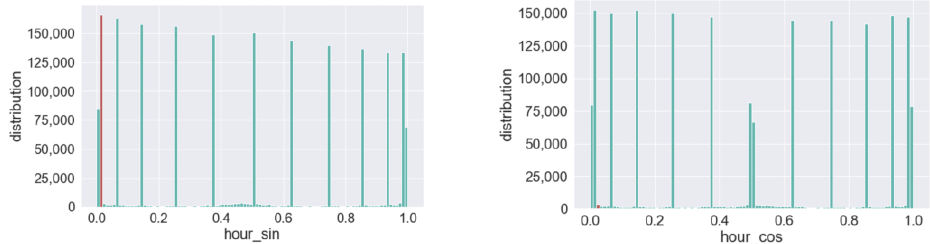
Figure 6. The distribution of the date features (day sin, day cosine, hour sin, and hour cosine).